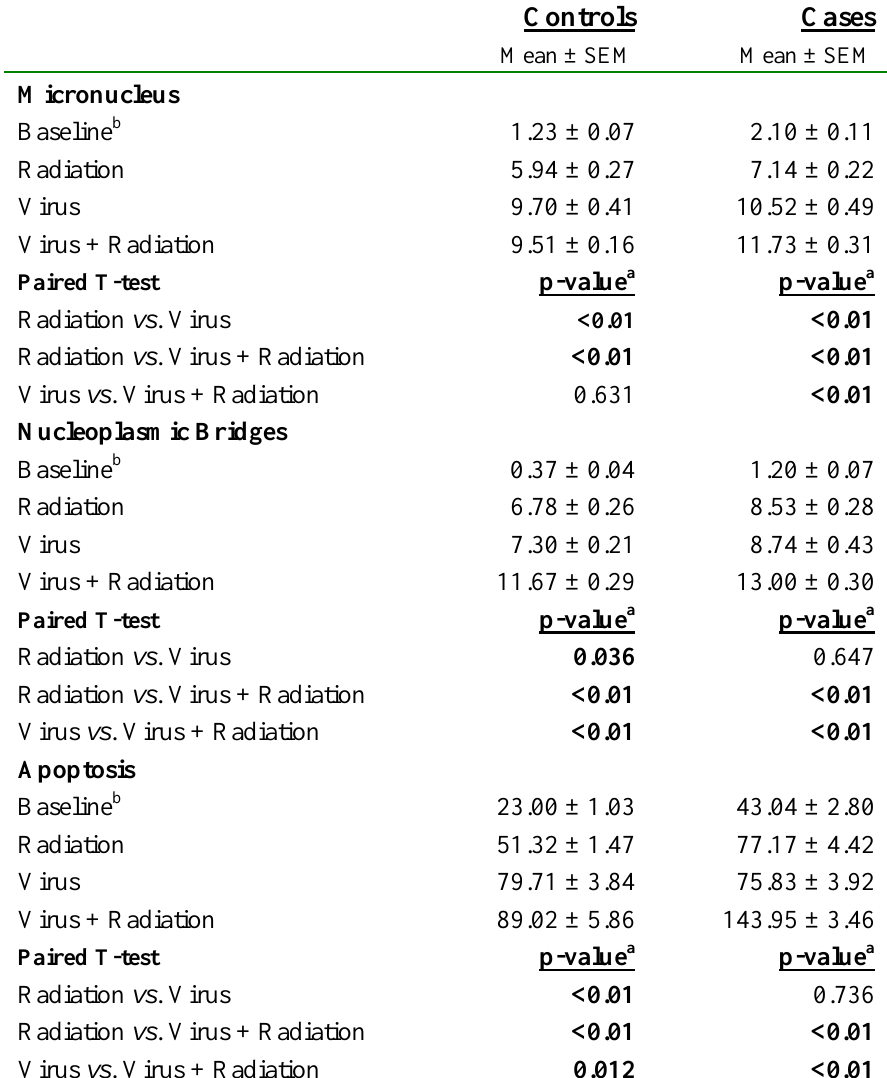
Table 1. Comparison between Treatments among Cases and Controls (Mean ±